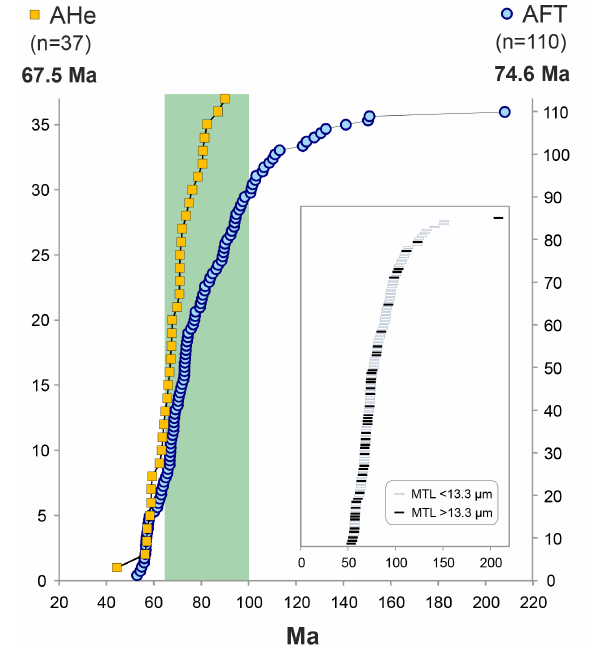
Figure 6. Cumulative frequency distributions of apatite fission- track (AFT) and apatite (U–Th) / He (AHe) ages from the study area. Bold numbers indicate the medians of the two datasets. The green area indicates the time interval of Late Cretaceous. The inset highlights the fact that long mean track lengths (MTLs) are mostly associated with AFT ages younger than ∼